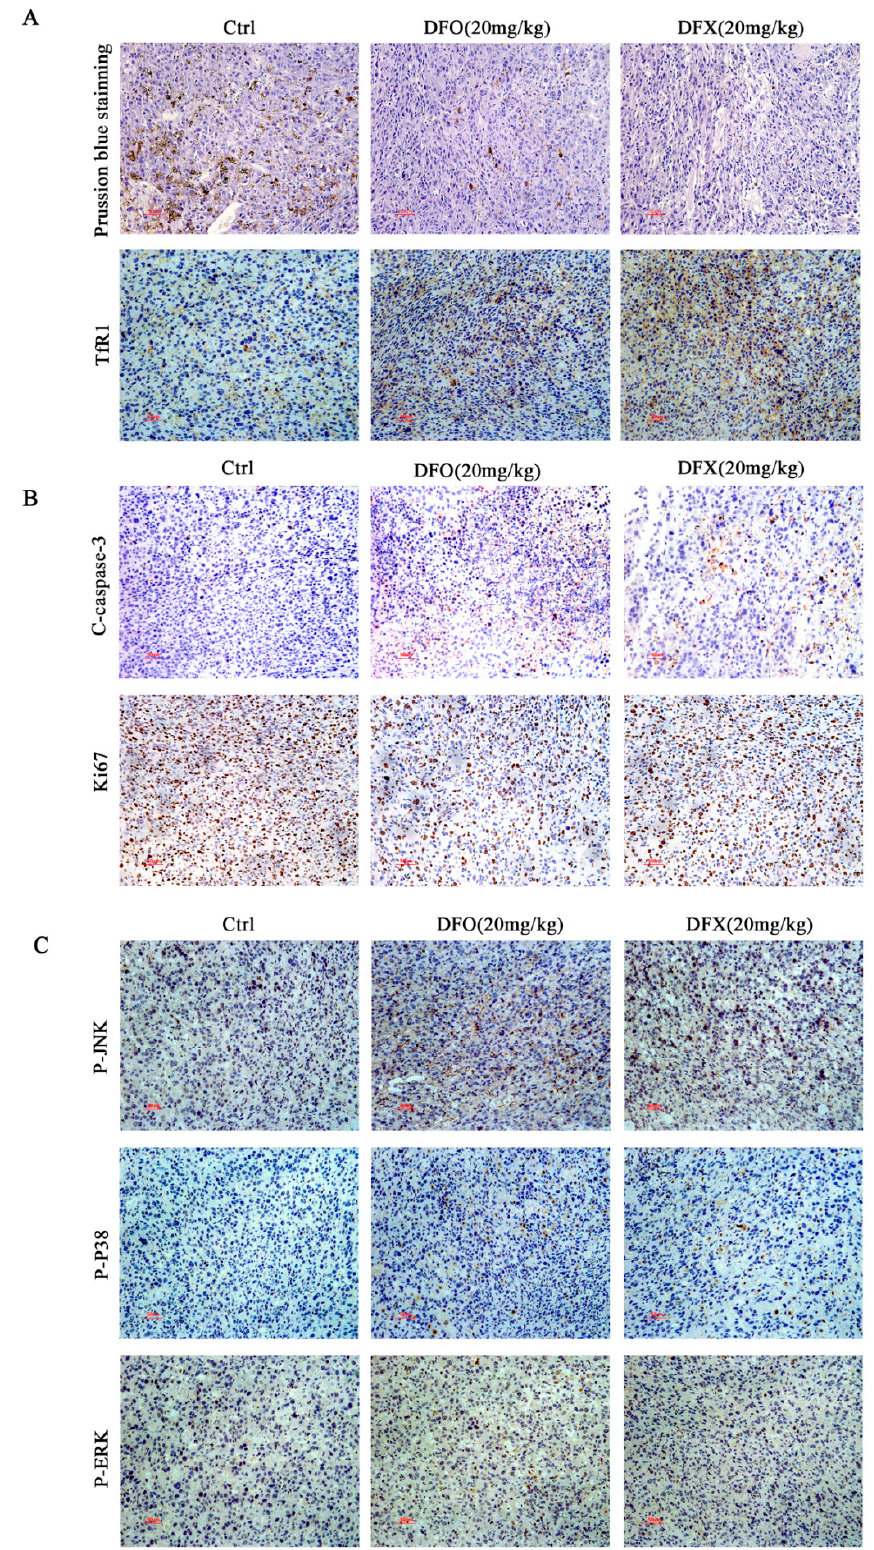
Figure 8. Effect of iron chelators on iron metabolism and MAPK pathway in tumor tissue. ( A ) Prussian blue staining analysis of tumor tissue and expression of TfR1 in tumor tissues. ( B ) C-caspase-3 and Ki67 immunohistochemical analysis. (C) P-JNK, P-P38 and P-ERK1/2 immunohistochemical analysis.